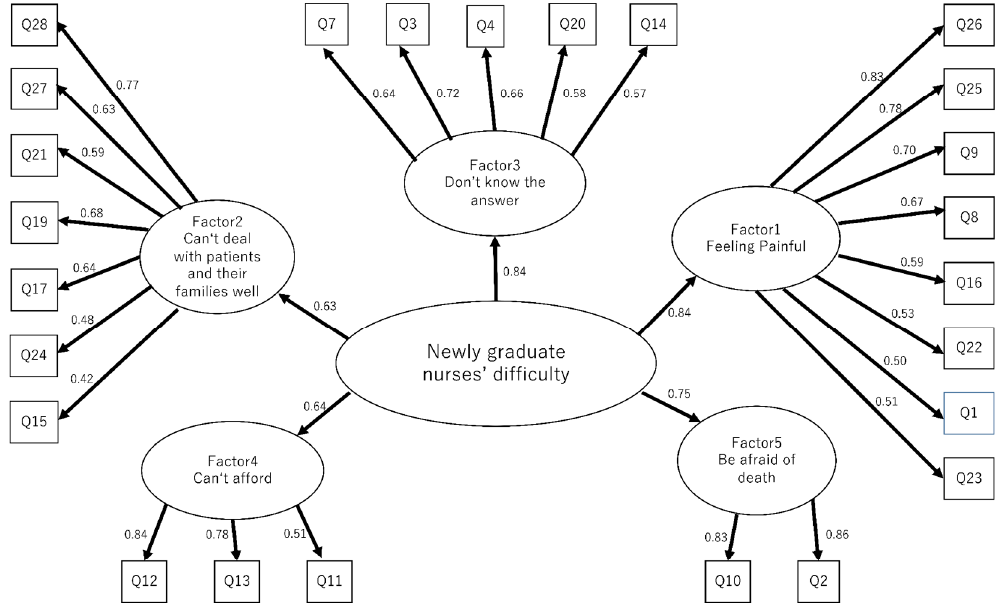
Figure 1. Results of the confirmative factor analysis. Note: The model fitness index was X 2 = 632